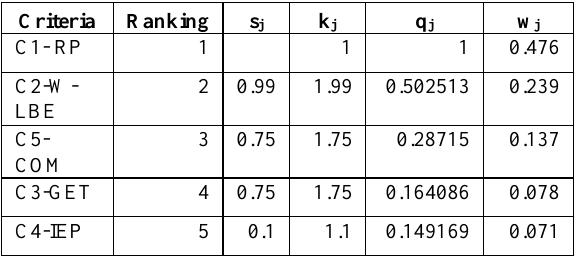
Table 7: SWARA Weighting Results for DM 5 Criteria